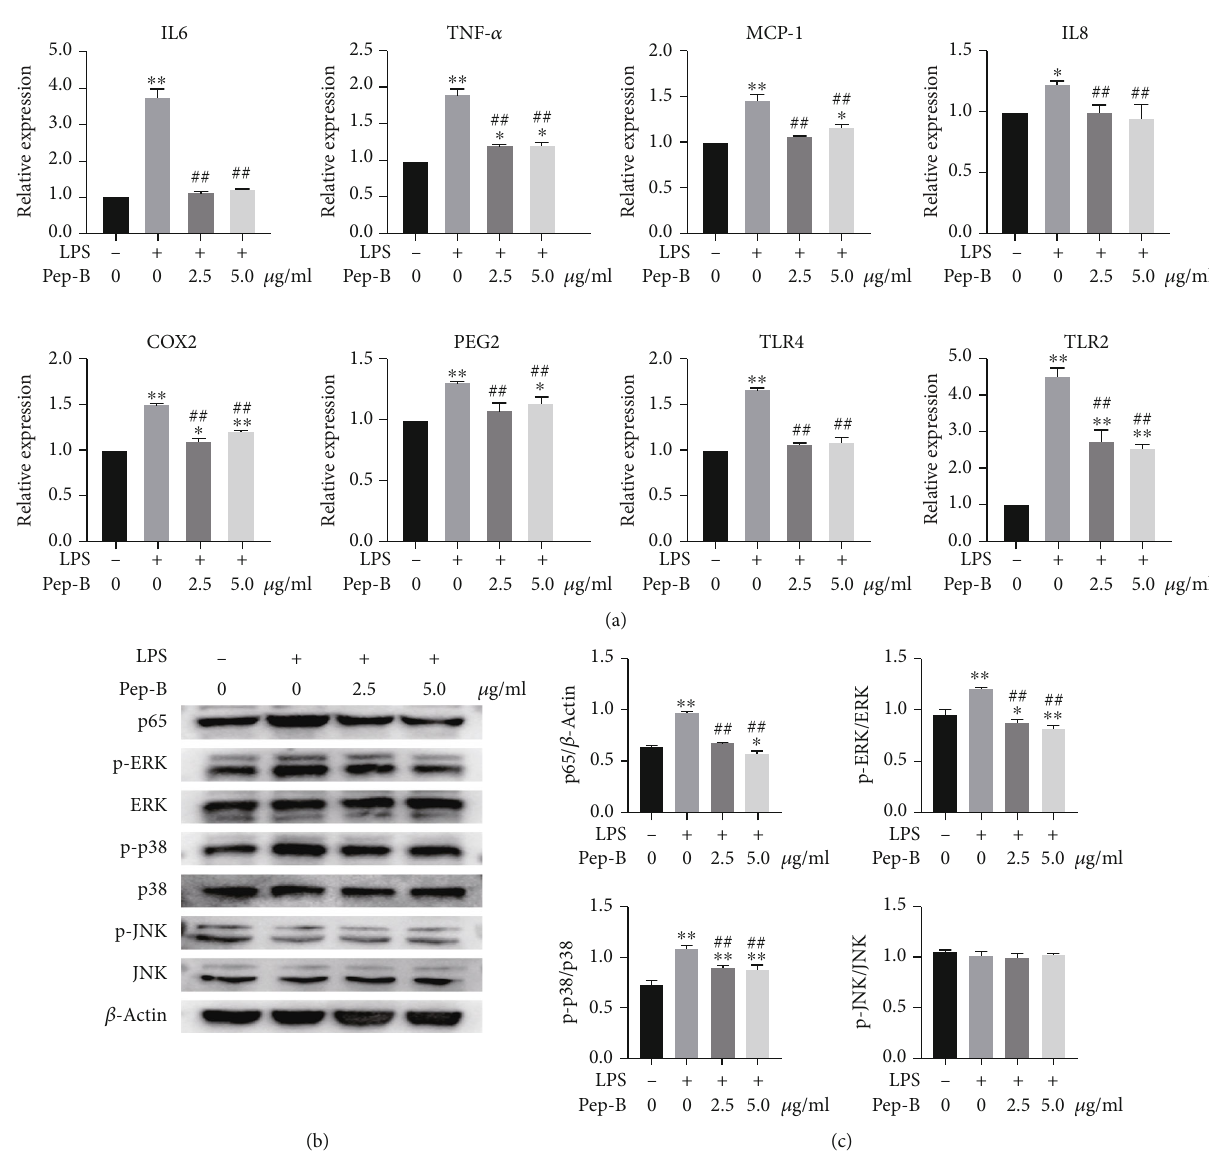
Figure 4: Anti-in fl ammatory e ff ects of Pep-B in hDPSCs. Cells were treated with LPS (1 μ g/ml) in the presence or absence of Pep-B (2.5, 5 μ g/ml). (a) qRT-PCR analysis to quantify in fl ammatory marker gene expression of di ff erent groups in hDPSCs. (b) The protein expression of p65, phospho-ERK, phospho-p38, and phospho-JNK was determined by means of western blot analysis. (c) Quanti fi cation of the band density observed in (b) determined using ImageJ software. ∗ P < 0 : 05 , ∗∗ , ## P < 0 : 01 , ∗ represents comparison with the control group, # represents comparison with the LPS